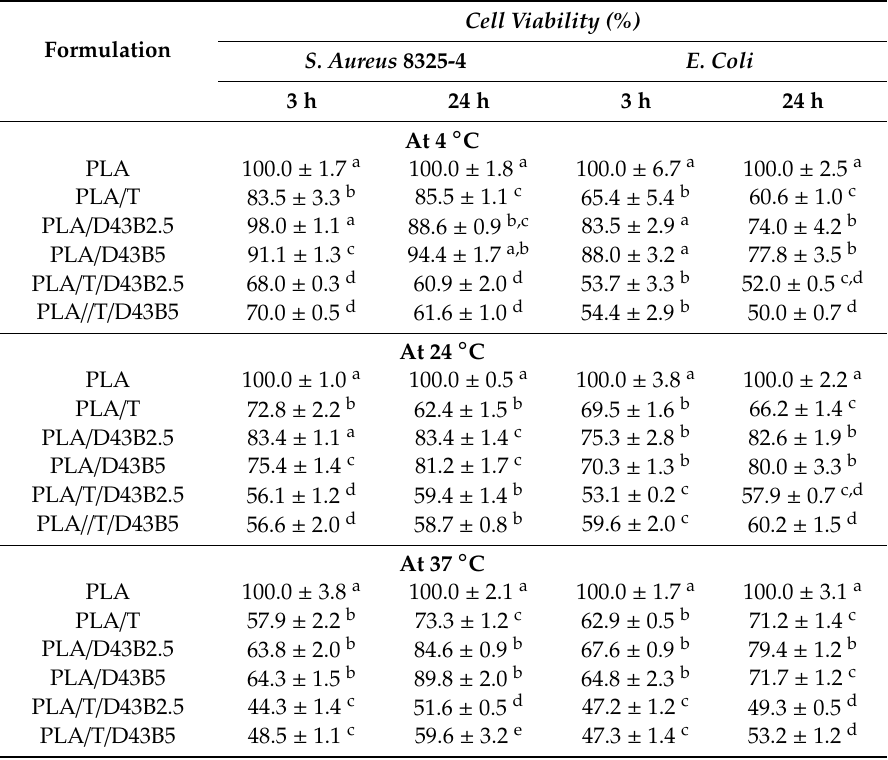
Table 2. Antibacterial activity of PLA-based nano-biocomposite films obtained at 2 incubation times (3 h and 24 h) and 3 di ff erent temperatures (4, 24 and 37 ◦ C) against E. coli and S. aureus 8325-4, expressed as cell viability